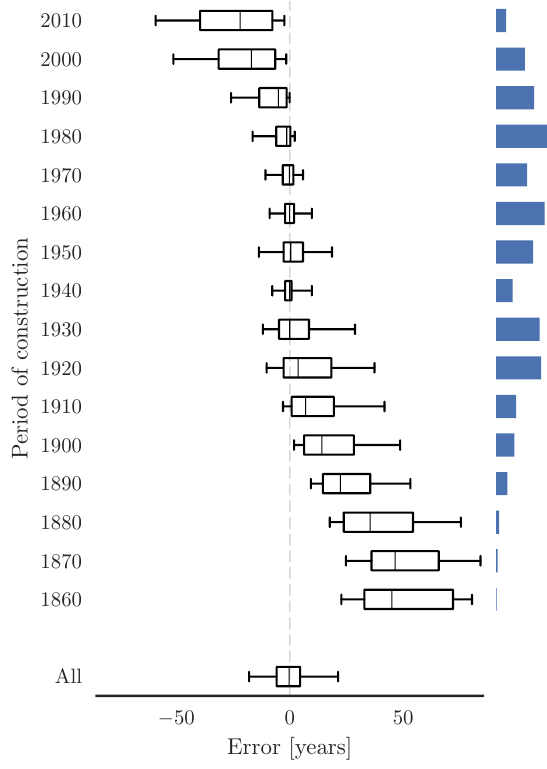
Figure 7. Errors in model 2 classified by period (decade) of con- struction with the indication of the quantity of the relative sample size (histogram on the right).